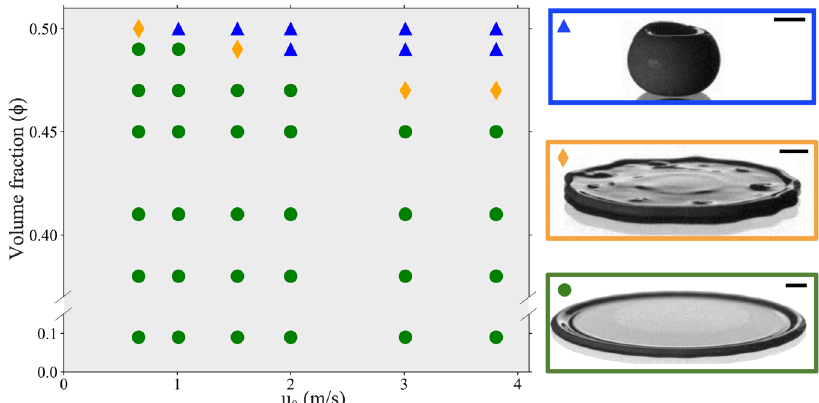
Fig. 3 State diagram of colloidal drop impact. ϕ − u 0 state diagram summarizing impact regimes; representative snapshots corresponding to these regimes are shown on the right. Green circles denote simple spreading behaviour, which dominates the low ϕ , low u 0 region. Orange diamonds indicate that transient pockets of localised solidi fi cation were observed during spreading. Blue triangles correspond to the partial/full solidi fi cation regime, where the bottom portion of the drop jams after impact, but a shrinking region at the top remains fl uid. Scale bars are 1 mm.